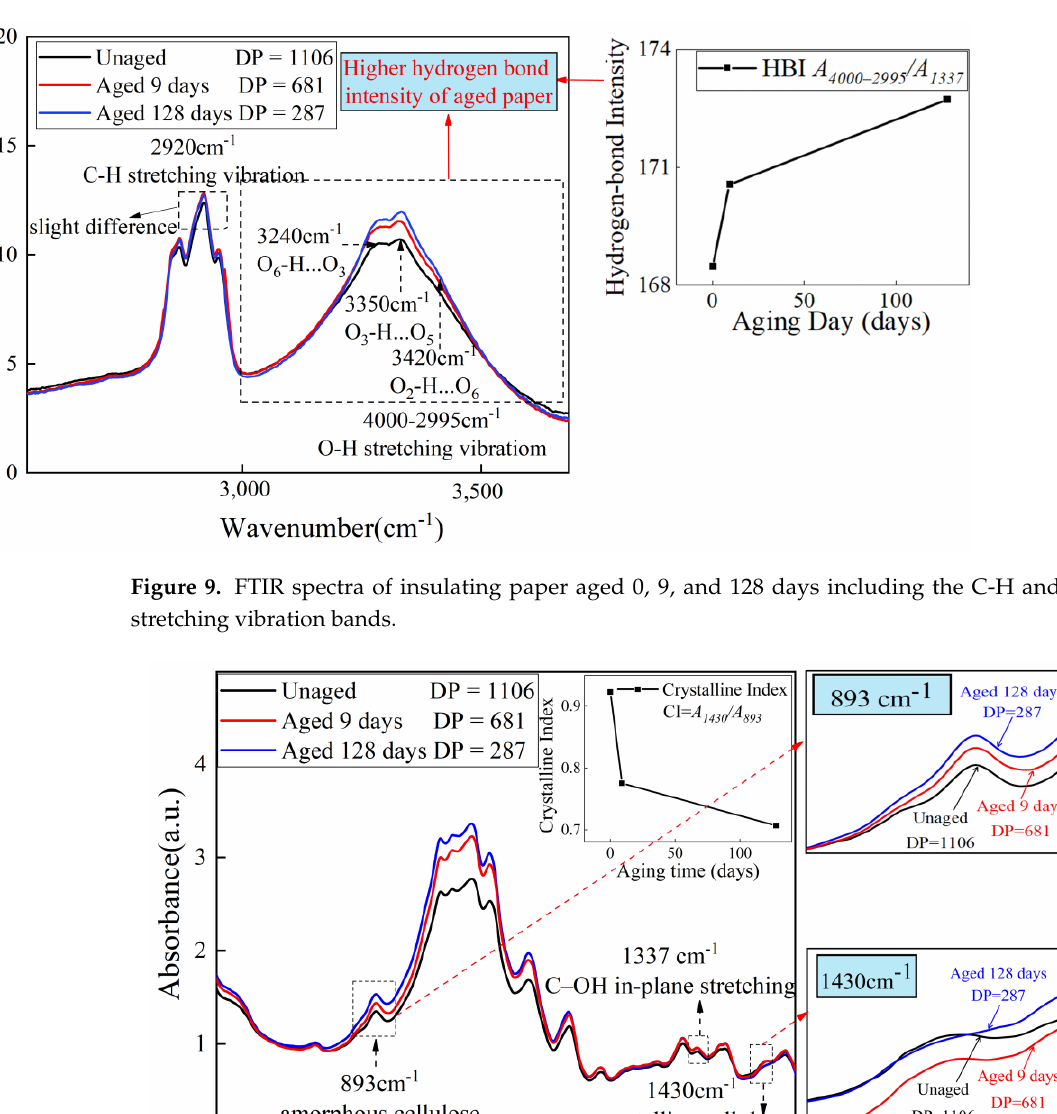
Figure 9. FTIR spectra of insulating paper aged 0, 9, and 128 days including the C-H and O-H stretching vibration bands.